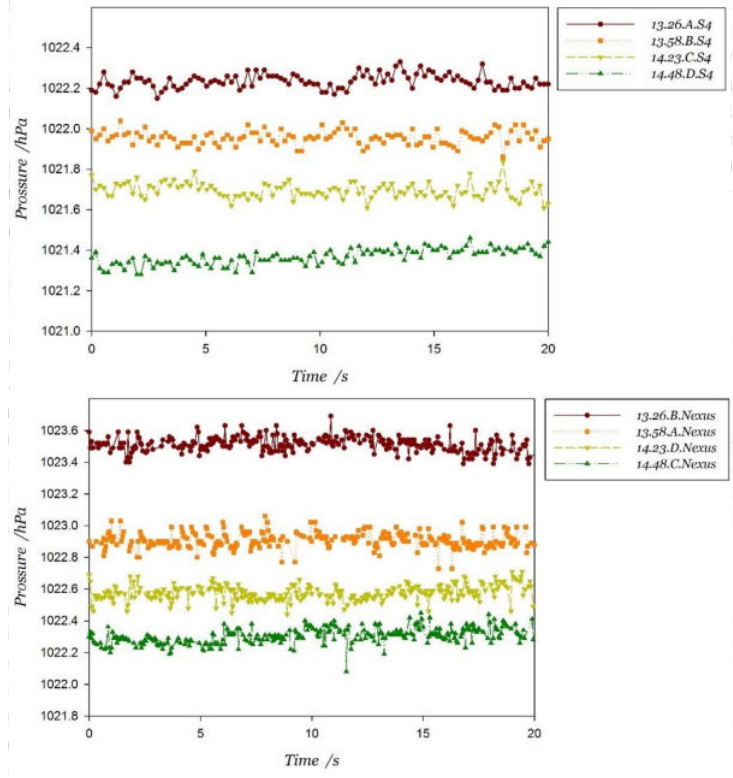
Figure 6. Air pressure data measured by two smartphones in stationary state. Table 3. The mean and the difference of the pressure (hPa) measured by mobile terminals.